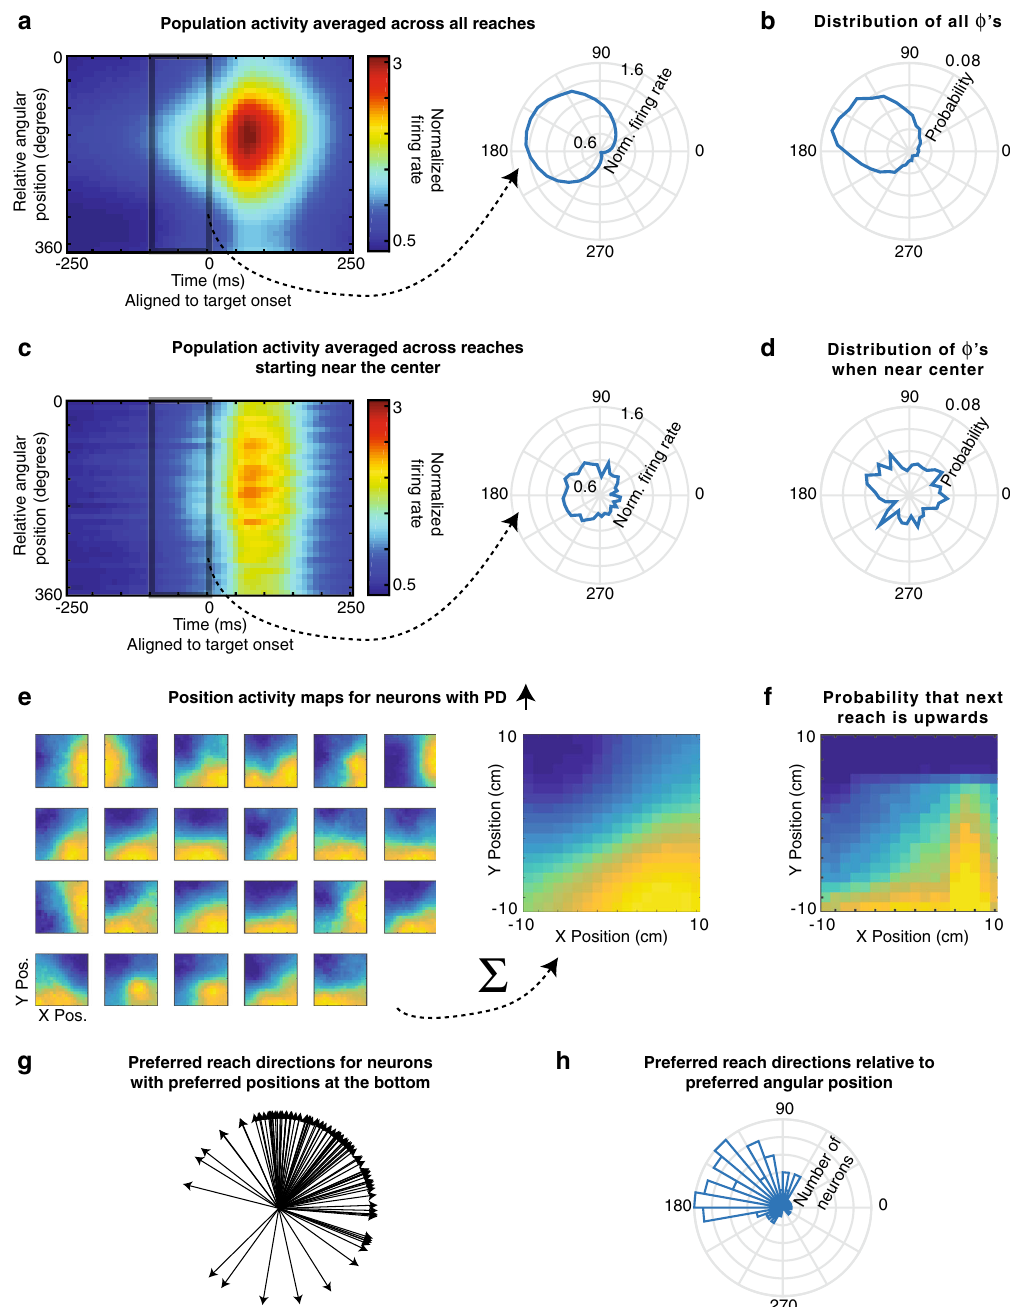
Fig. 4 The PMd population jointly represents the distribution of upcoming reaches. a Left: The average normalized fi ring rate of all PR neurons, over time, as a function of relative angular hand position. For each neuron, the relative angular position is the preferred direction of the neuron minus the angular hand position. Activity is normalized and averaged across all PR neurons. Right: The average normalized fi ring rate in the 100 ms prior to target onset, plotted as a function of the relative angular hand position. b The distribution of upcoming movement directions relative to angular hand positions. This is duplicated from Fig. 1f for easy comparison with panel a . c , d Same as panels a and b , but for only for reaches starting near (within 2 cm of) the center. Note that panel d is duplicated from Fig. 1g. e Left: Position activity maps for example PR neurons with preferred movement directions that are oriented upwards. The position activity maps show the neurons ’ activity as a function of hand position (blue is low; yellow is high) from − 100 to 50 ms surrounding target onset. Right: The sum of the position maps for all PR neurons, when their preferred directions are oriented upwards. f A map showing the probability that the next movement will be upwards, as a function of initial hand position. g Preferred reach directions for all PR neurons, when space is rotated so that their preferred hand angular position is oriented to be at the bottom (270°). h A histogram of preferred reach directions of all PR neurons relative to their preferred angular hand position (the reach PD minus the preferred angular hand